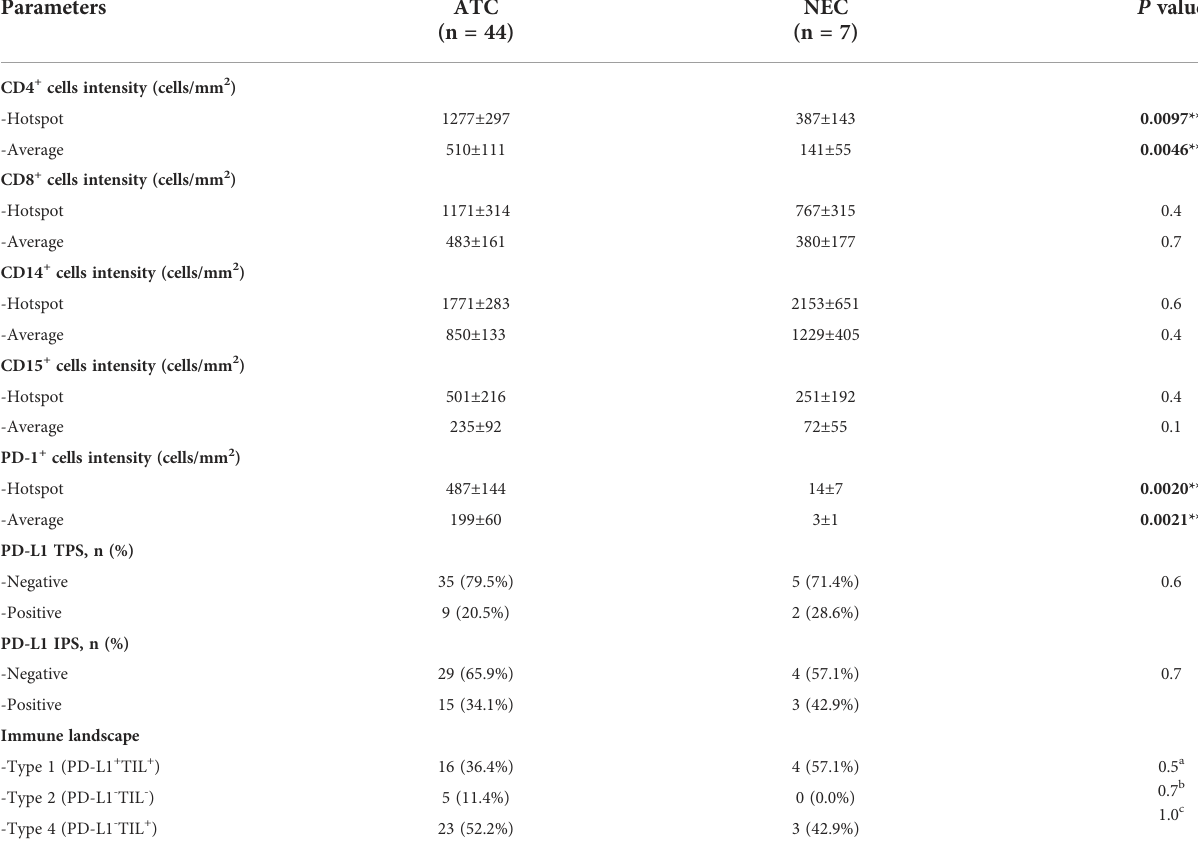
TABLE 2 Comparison analysis of immune landscape between well-differentiated ATC and poorly-differentiated